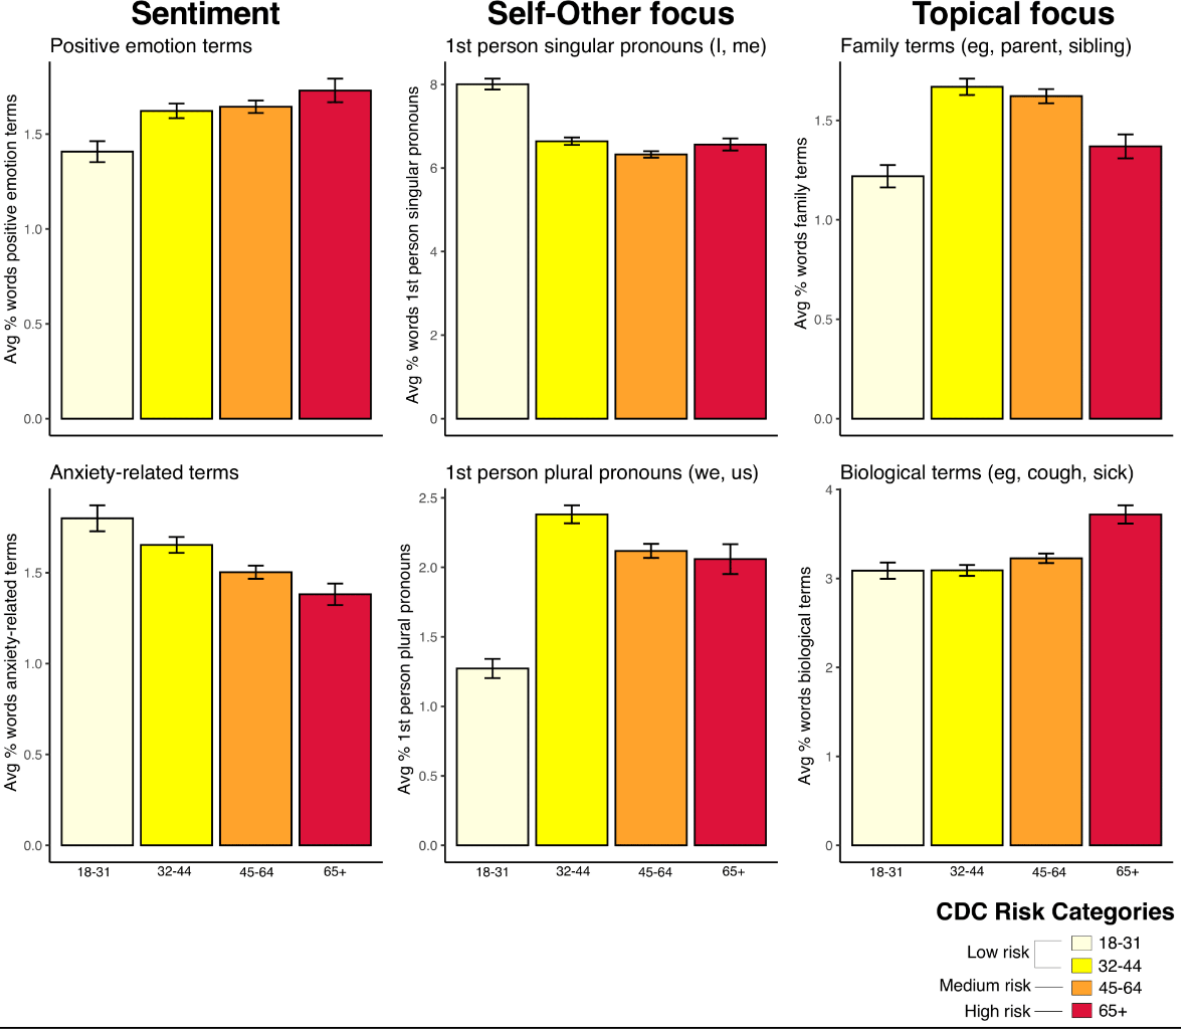
RQ1: Topical Salience in Describing the Impact